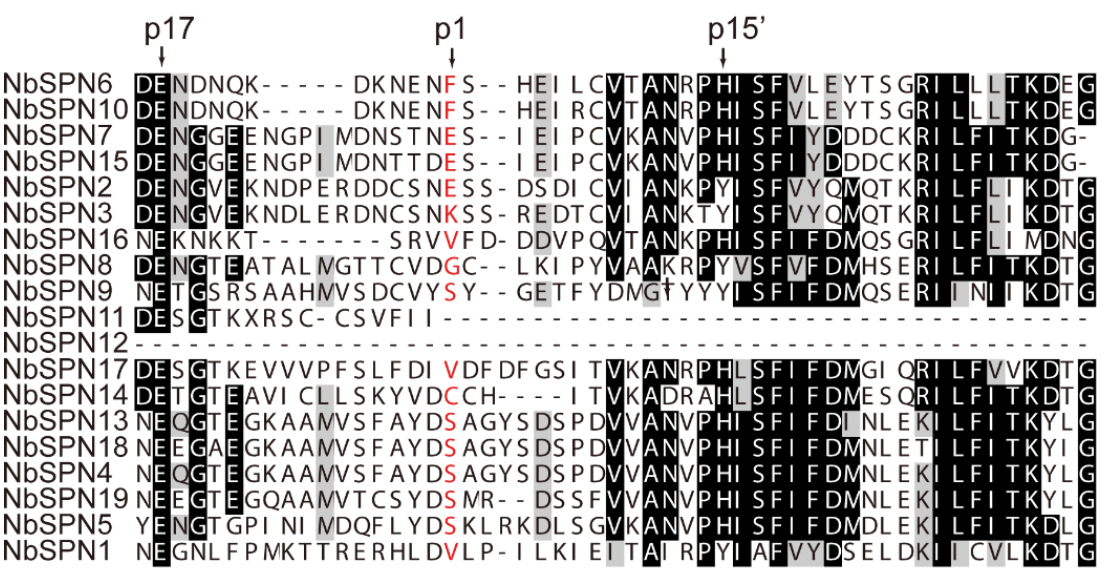
Figure 2. Alignment of the RCL region of N. bombycis serpins. The conserved residues p17 and p15′ were labelled in the hinge region of inhibitory serpins above the alignment. Predicted P1 residues are in red.